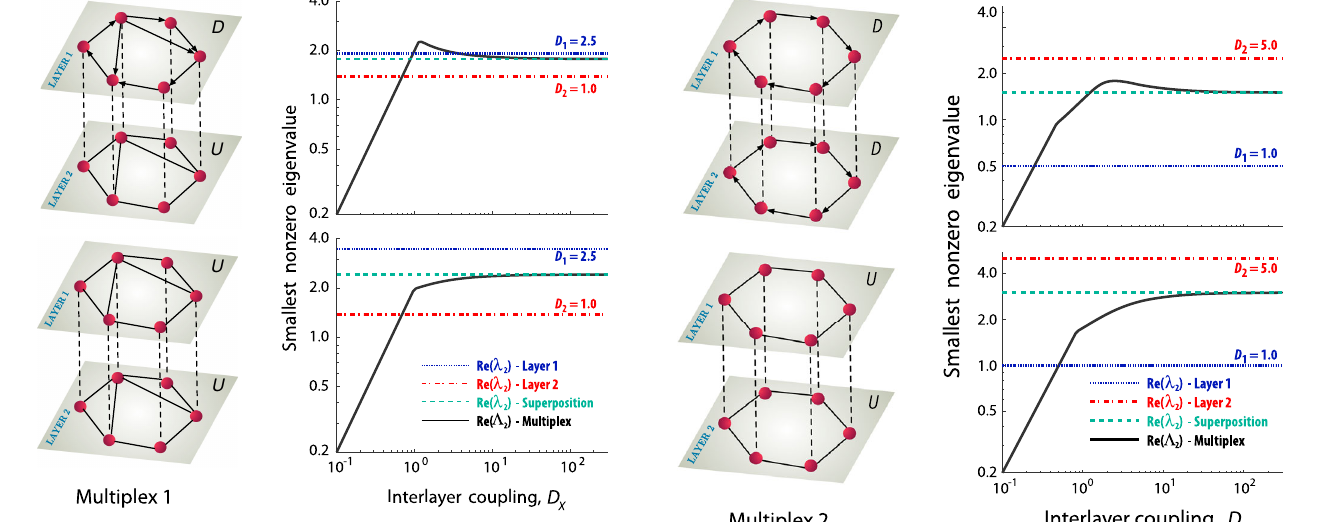
FIG. 9. Characteristic rate of convergence to stationary state solution of a continuous-time Markov chain on multiplex 2 and its undirected counterpart.